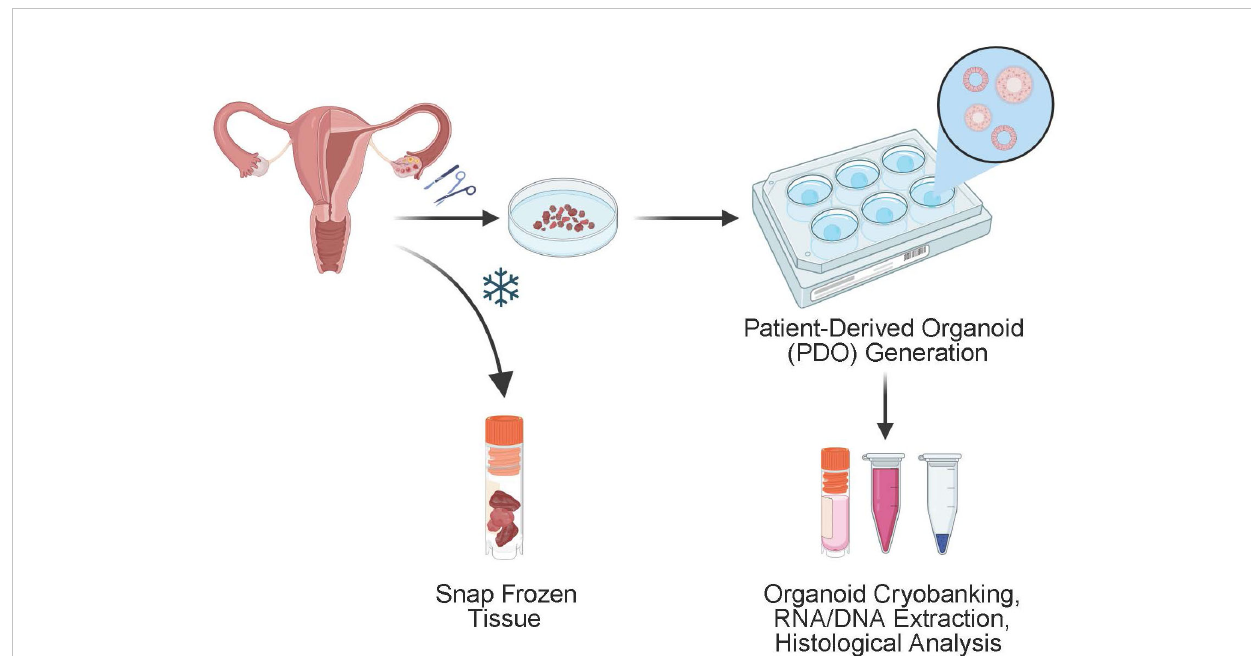
FIGURE 1 Schematic of the generation of endometrial organoids derived from patient surgical specimens. Subsequent culturing is performed to create patient derived organoids which can be further analyzed for DNA and RNA extraction and histological analysis. Remaining specimen is frozen for storage and can be thawed and used for continued tissue